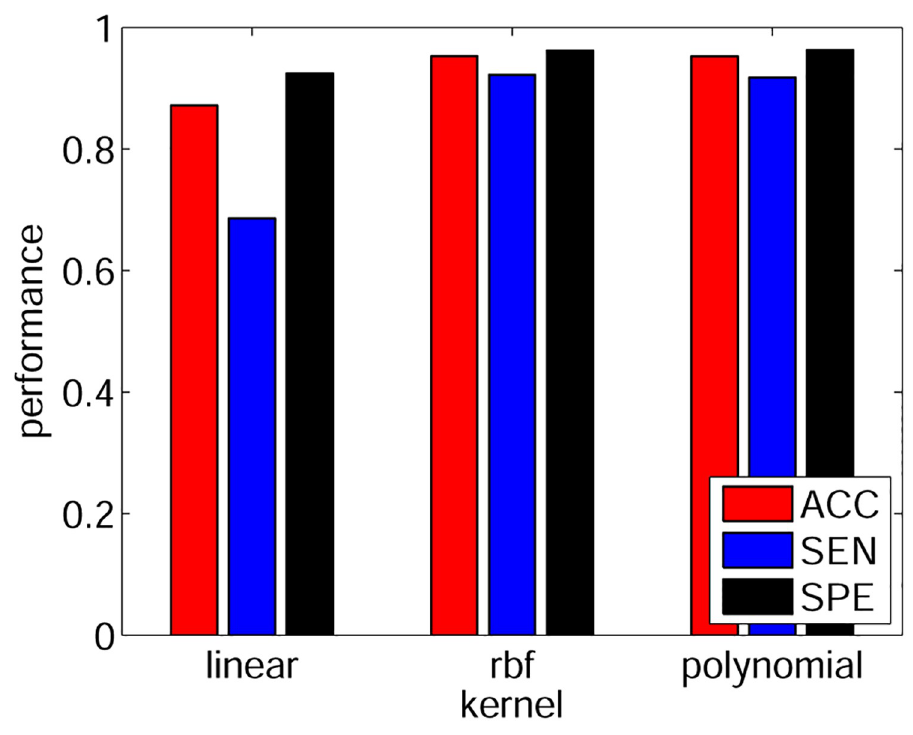
Fig 3. The performance with different kernel